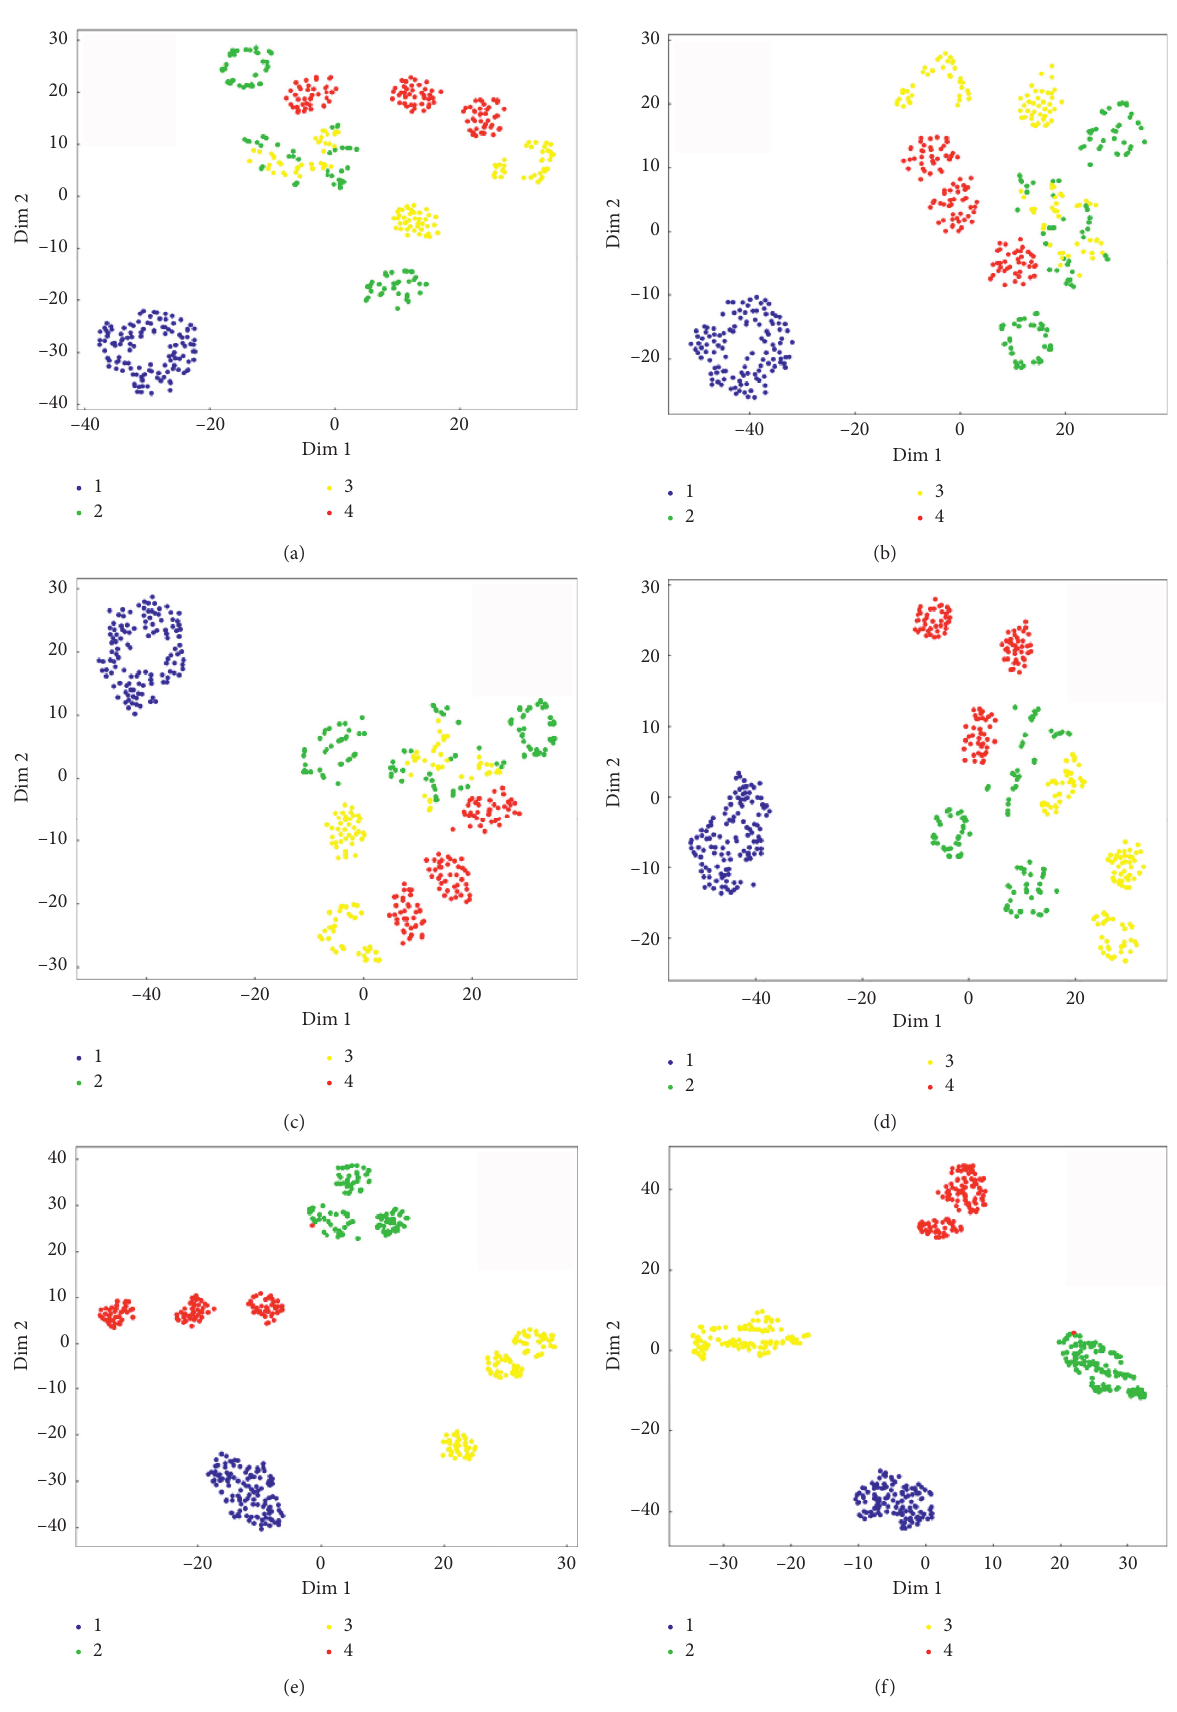
Figure 8: Visualization of the learned features from different layers of TDRN: (a) input; (b) SRB1; (c) SRB2; (d) SRB3; (e) IRB6; (f)